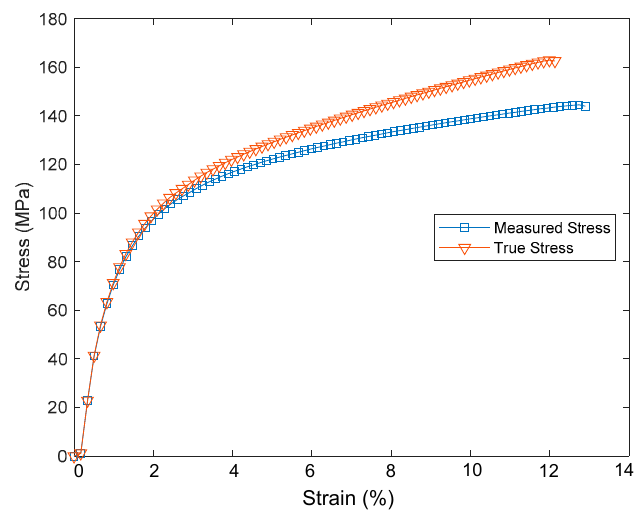
Figure 5. Comparison of measured and true stresses.